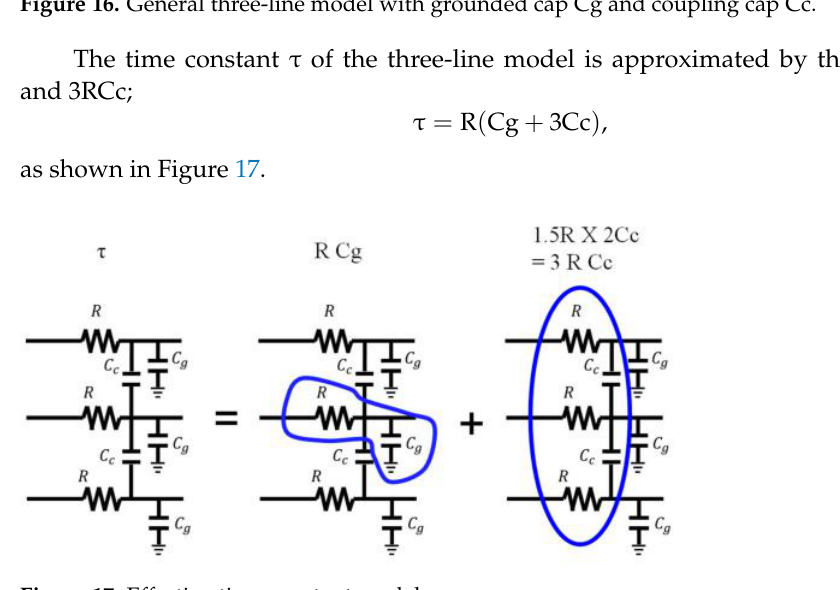
Figure 17. Effective time constant model.